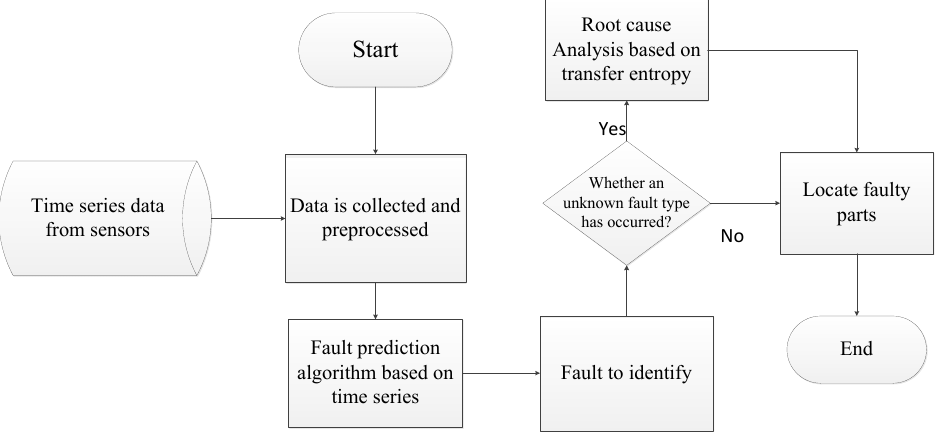
Figure 1. The process of the fault diagnosis